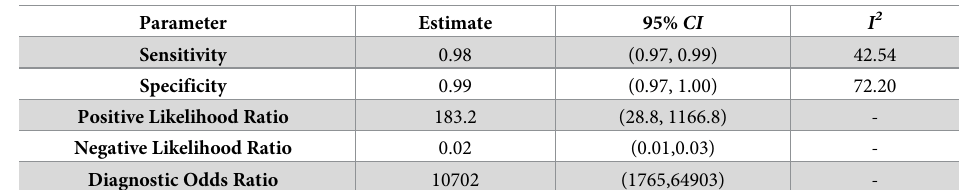
Table 3. Pooled effect